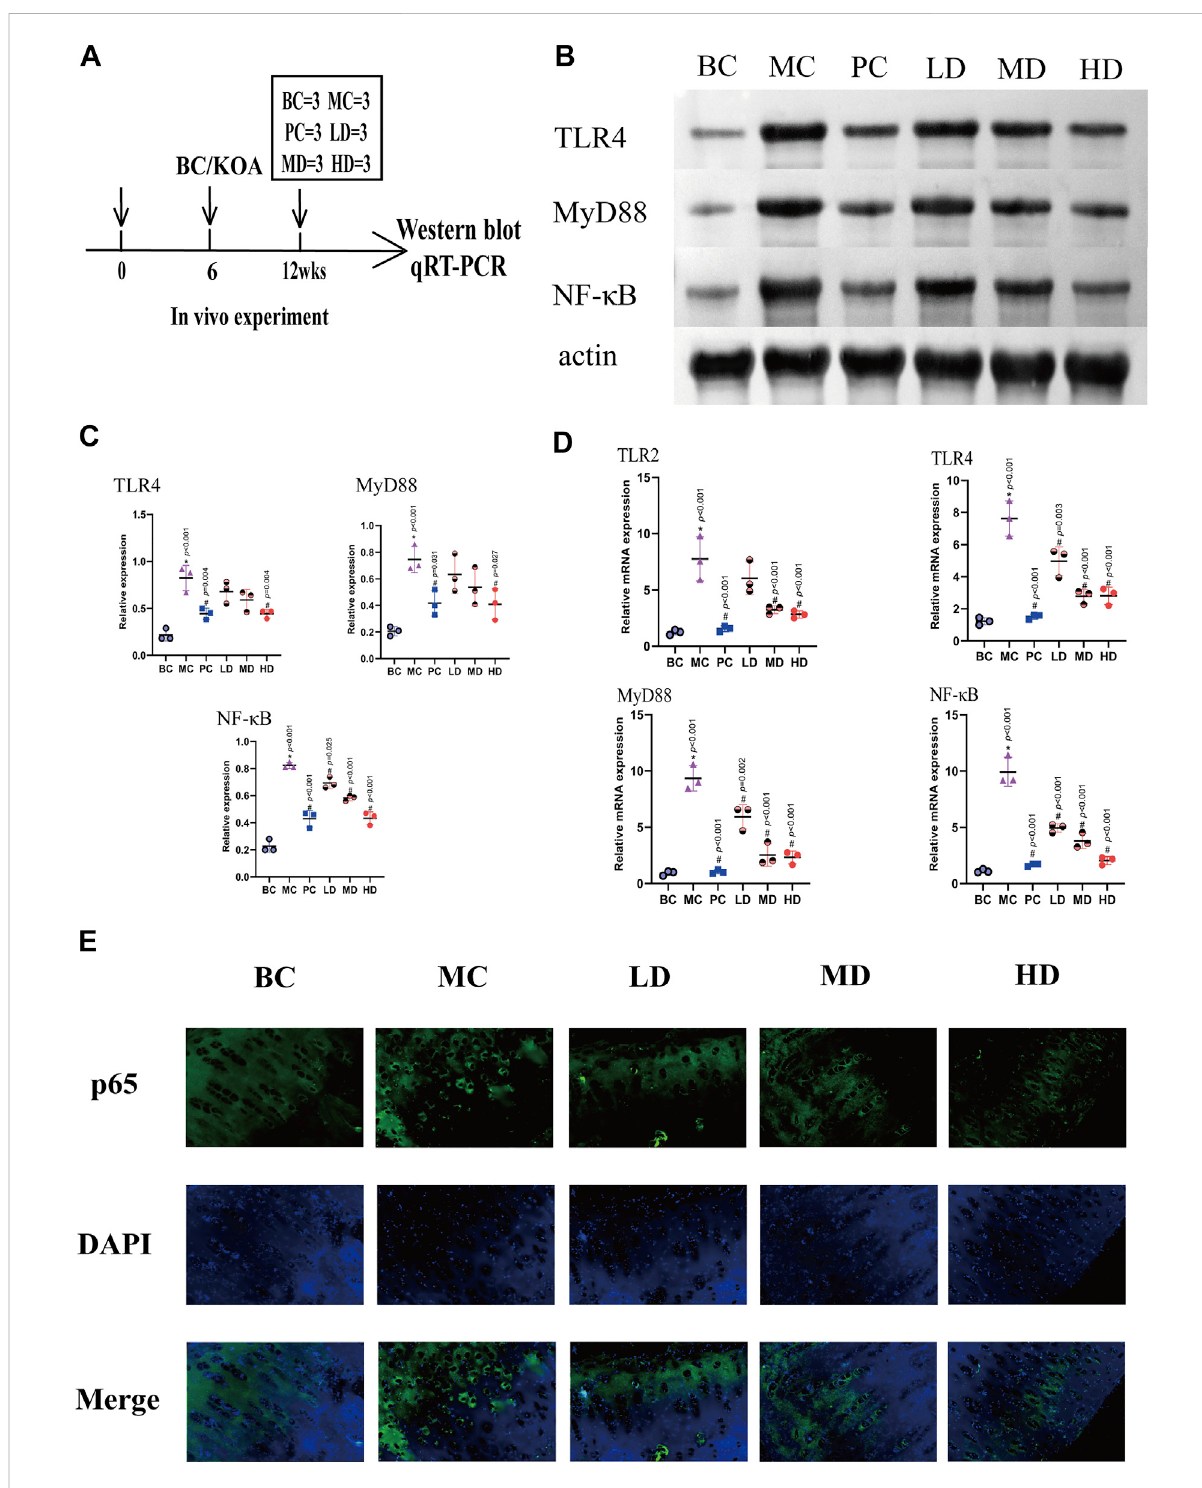
FIGURE 6 ZFTGinhibitstheTLR2-4/MyD88/NF-kBsignalingpathwayinalleviatingkneeosteoarthritisinrabbits. (A) Experimentaldesign.Therabbitswere killed for Western blot and qRT-PCR analysis at 12 weeks ( n = 3/group). (B,C) Western blot analysis of TLR4, MyD88, and NF-kB protein expression with actin serving as a protein loading control. (D) qRT-PCR analysis of TLR2, TLR4, MyD88, and NF-kB mRNA expression. (E) Immuno fl uorescence observation of NF- κ B p65 protein expression. The images are magni fi ed 400×. One-way analysis of variance was used for comparing protein andgeneexpression.Thedataarepresentedasthemean±SD.* p < 0.05,vs.BCgroup;# p < 0.05,vstheMCgroup.Speci fi c p -valuesforeachpairof comparisons are